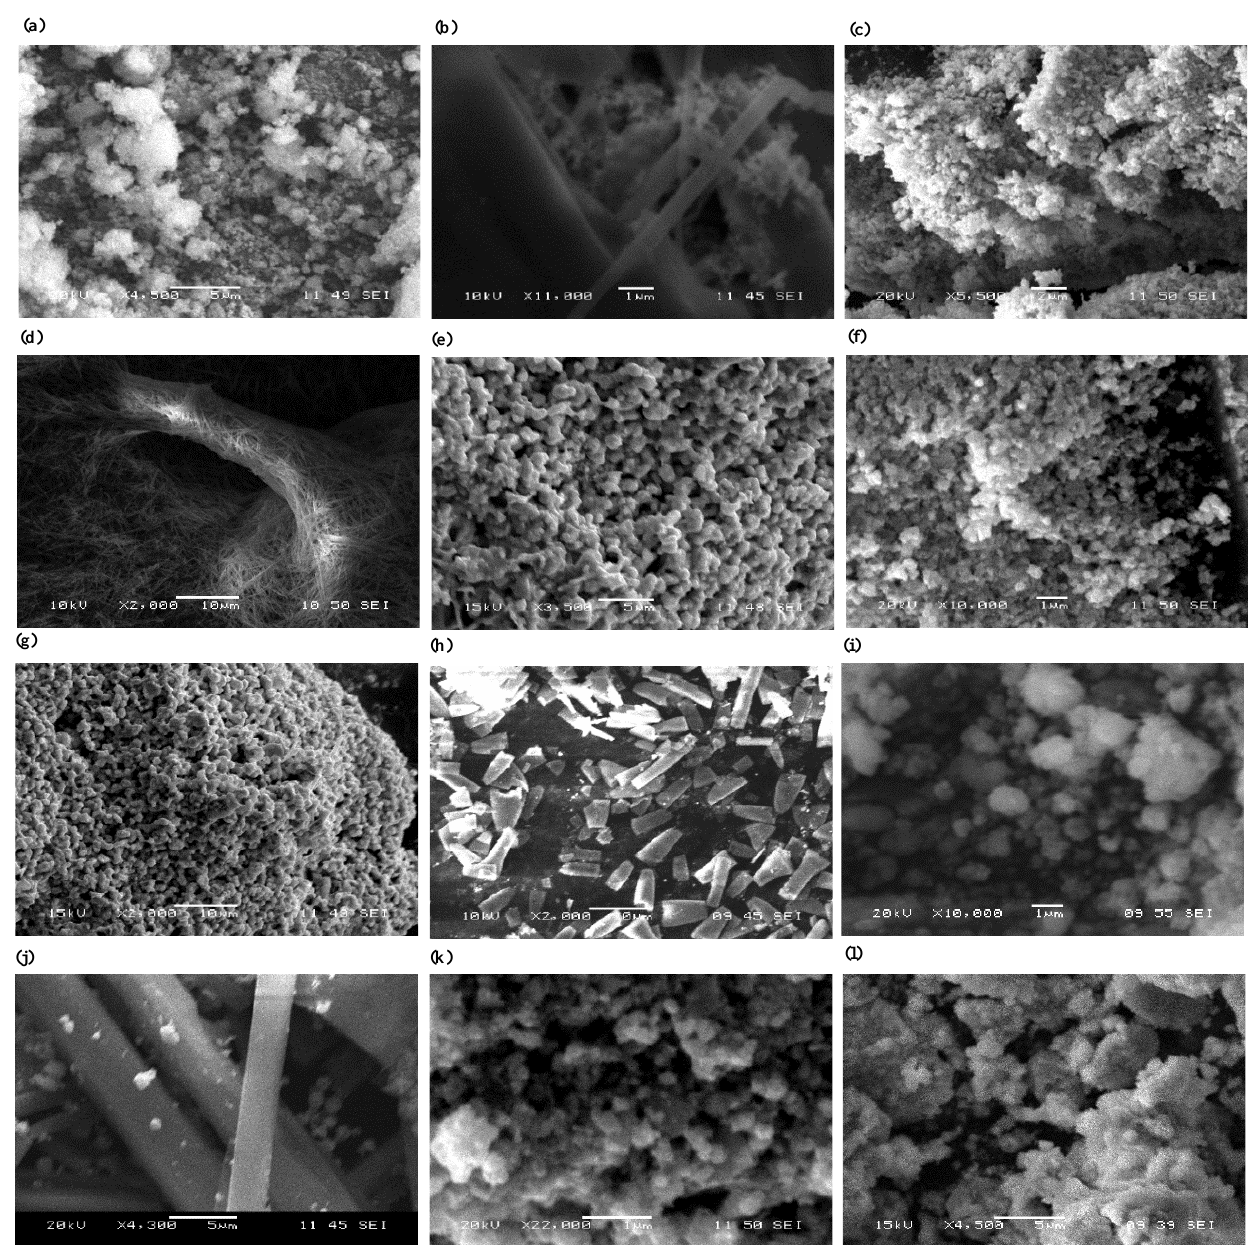
Figure 7. SEM images of the twelve functionalized silver nanoparticles. ( a ) 1-np (4500 × ), ( b ) 2-np (11,000 × ), ( c ) 3-np (5500 × ), ( d ) 4-np (2000 × ), ( e ) 5-np (3500 × ), ( f ) 6-np (10,000 × ), ( g ) 7-np (2000 × ), ( h ) 8-np (2000 × ), ( i ) 9-np (10,000 × ), ( j ) 10-np (4300 × ), ( k ) 11-np (22,000 × ), ( l ) 12-np (4500 × ).